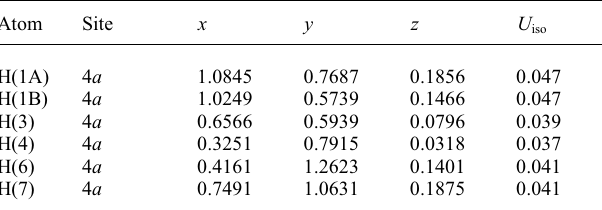
Table 2. Atomic coordinates and displacement parameters (in Å 2 )